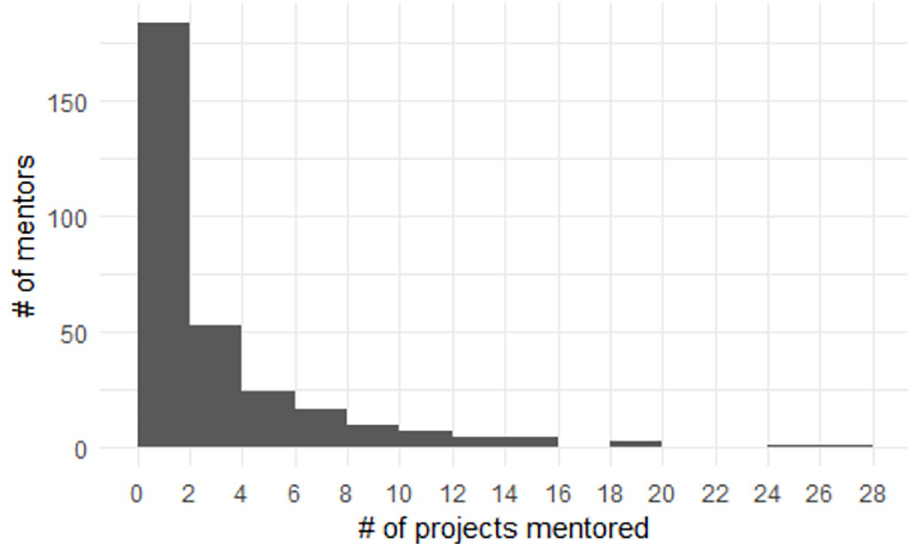
Fig 1. Distribution of number of mentored projects.